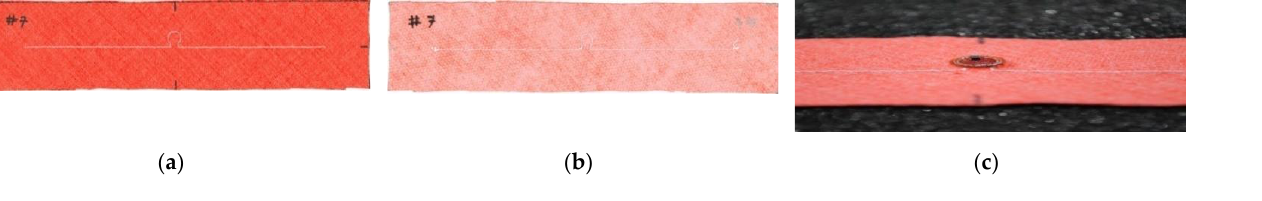
Figure 18. An example of the RFIDtex transponder — sample A7: ( a ) front of antenna; ( b ) back of antenna; ( c ) antenna and microelectronic module.